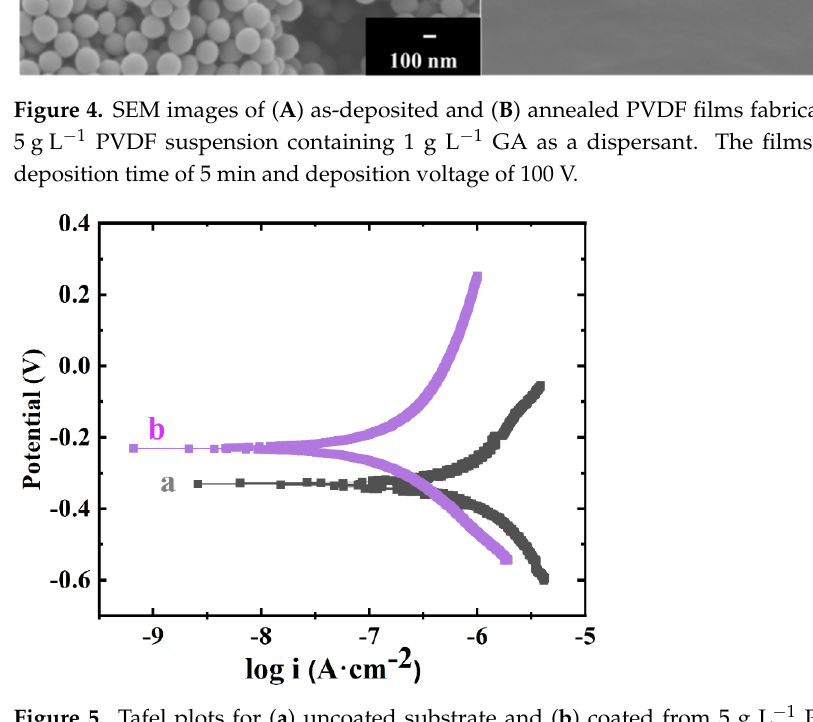
Figure 6. Bode plots for ( a ) uncoated substrate and ( b ) coated from 5 g L − 1 PVDF suspensions con- taining 1 g L − 1 GA and annealed at 200 °C. PVDF films were obtained at deposition time of 5 min and deposition voltage of 100 V. As pointed out above, GA is an important dispersant for the EPD of oxide materials [18], which allows for catecholate-type bonding to metal atoms on the particle surface. Therefore, it was hypothesized that GA can act as a co-dispersant for PVDF and silica particles. The co-EPD of PVDF and silica was performed using micron-size silica and na- nosilica. Figure 7 shows SEM images of coatings prepared from PVDF and silica particles and dispersed using GA. The SEM images at different magnifications showed crack-free coatings containing nanosilica or micron-size silica particles. The particles were incorpo- rated into the PVDF matrix as individual particles or agglomerates. The EPD of composite films was performed from suspensions with different concentrations of silica particles. Figure 8 shows films mass as a function of silica concentration in 5 g L − 1 PVDF suspen- sions, containing 1 g L − 1 GA. The deposition yield for suspensions, containing micron-size silica particles increased with increasing concentrations of particles in suspension. The increase in the deposition yield indicated the increased deposition of silica and the possi- bility of variations in coating composition. The deposition yield for suspensions contain- ing nanosilica increased in the concentration range of 0–4 g L − 1 and remained nearly con- stant at higher nanosilica concentrations. It is suggested that larger GA content is neces- sary for dispersion and deposition on nanosilica due to the larger surface area of this ma- terial. Indeed, a continuous increase in the deposition yield was observed with increasing nanosilica content in suspensions containing 5 g L − 1 PVDF and 2 g L − 1 GA (Figure S6). It is